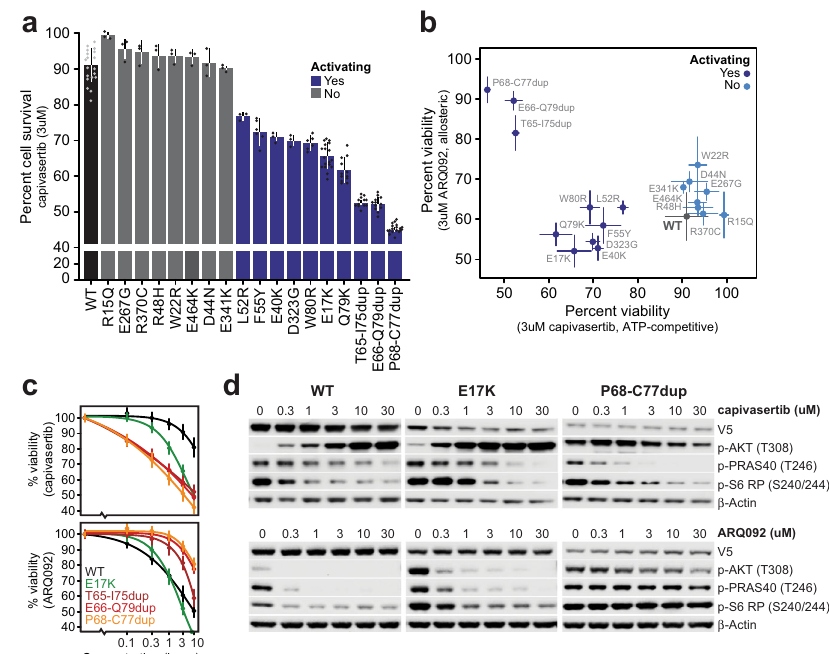
Fig. 4 Pre-clinical sensitivity of diverse AKT mutations to AKT inhibition. a The viability of MCF10a cells stably expressing either WT or the indicated mutations in AKT1 was assessed after treatment with 3 μ M of the ATP-competitive AKT inhibitor capivasertib. Legend indicates which of the alleles are activating. b As in panel A, cells expressing the indicated mutants were assessed for viability after treatment with either capivasertib or the allosteric inhibitor ARQ092. Points represent mean viability percentage and error bars indicate the 95% con fi dence intervals. For panels (a-b), mean viability was determined from at least two independent experiments. c MCF10a cells stably expressing wild-type AKT1, the known oncogenic E17K, or indel mutants were treated with indicated concentrations of capivasertib or ARQ092 (top and bottom, respectively), and cell viability was assessed 72 hours post- treatment. Results derived from 18 values from six independent experiments. d Whole-cell lysates from MCF10a cells expressing AKT1 WT, E17K, and P68- C77dup were harvested four hours post-treatment with either capivasertib (top) or ARQ092 (bottom), and pathway inhibition was assessed by western blot. Results are representative images from at least two independent experiments. Error bars in panels ( a ) and ( c ) represent standard deviations from the mean. Source data are provided as a Source Data fi